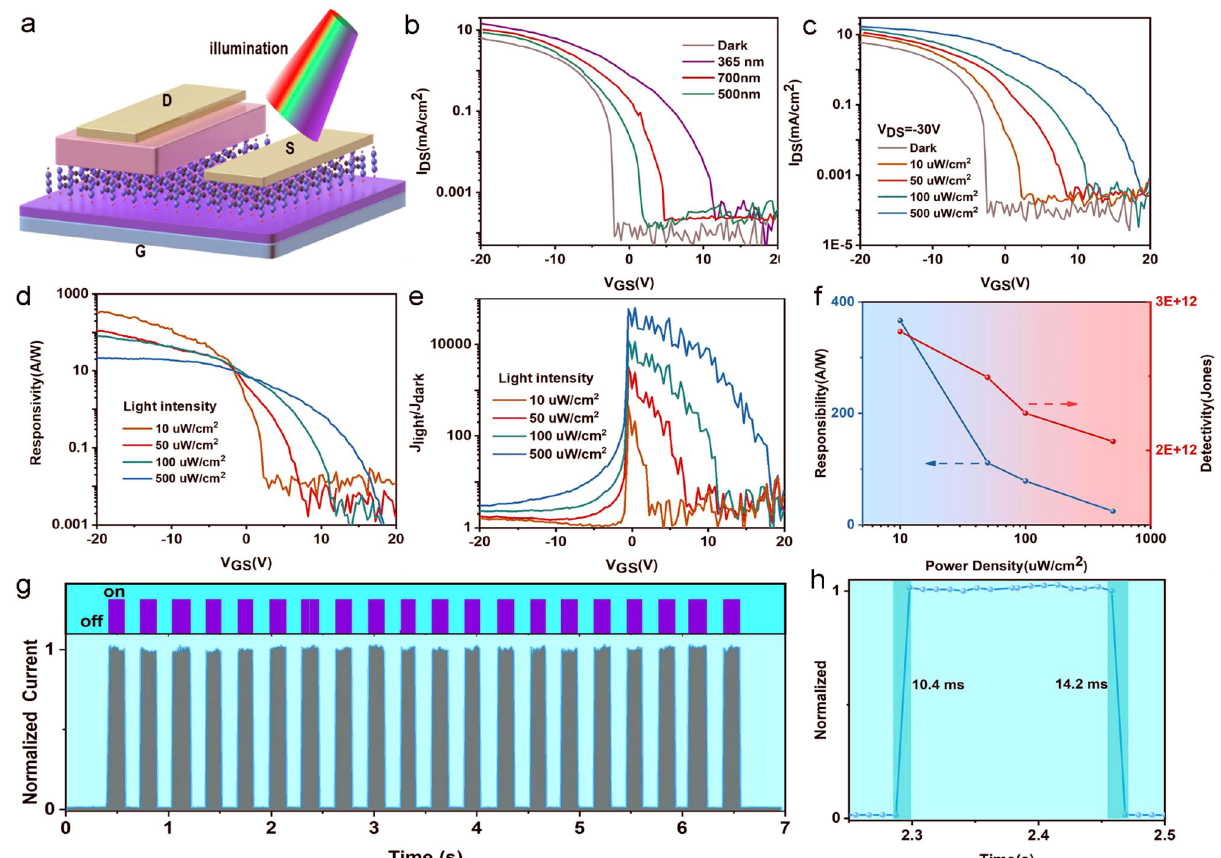
Fig. 5 The optoelectronic performance of MVOFET. a The schematic of MVOFET under illumination. b Transfer curves of MVOFET under dark and different wavelength incident light. c The transfer curves measured at different light intensity under 365 nm. d , e Responsivity and Photosensitivity as a function of gate voltage under different light intensity measured at 365 nm, respectively. f Responsivity and speci fi c Detectivity under different light intensity at 365 nm. g The real-time UV light response cycle test measured at V GS = 10 V and V DS = − 20 V. h A single light response under 365 nm, exhibiting a fast rising and falling time of 10.4 and 14.2 ms,